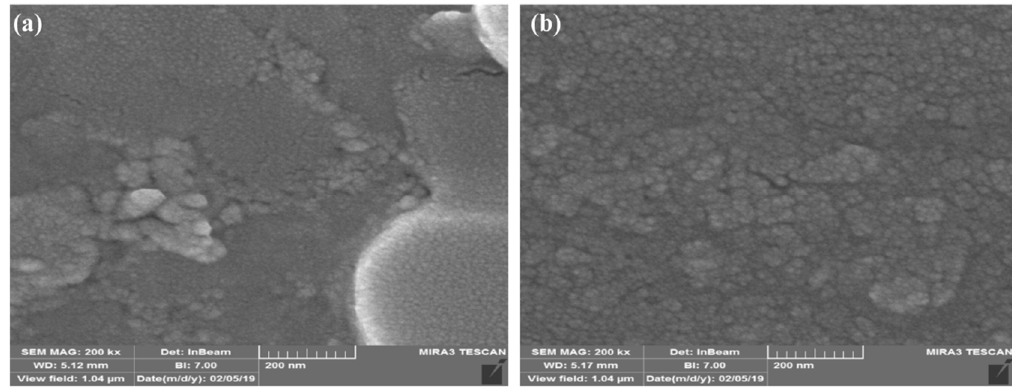
Figure 5. FE ‐ SEM results of ( a ) stealth liposome and ( b ) liposome. Figure 5. FE-SEM results of ( a ) stealth liposome and ( b ) liposome. Fibers 2021 , 9 , x FOR PEER REVIEW